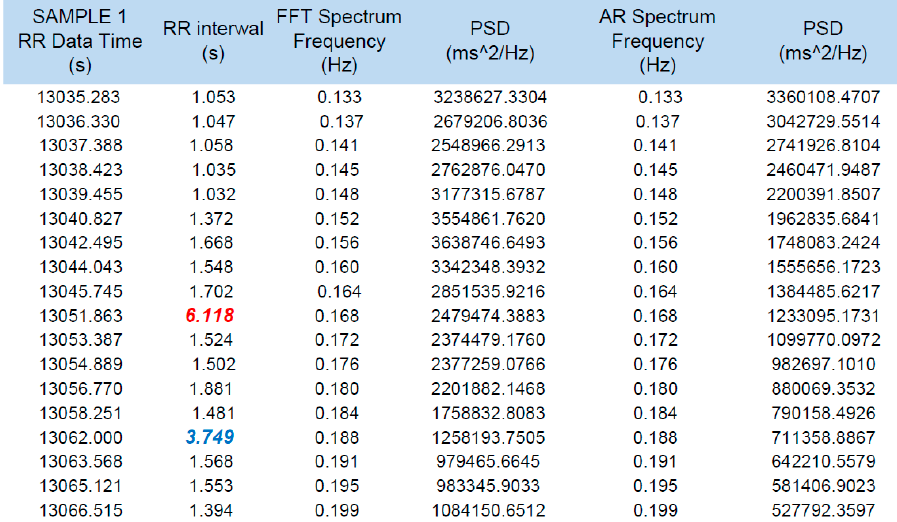
Figure 1. An example of a 30 s HRV printout recorded on an HRM that was compared with the ECG Holter recordings. The R-R interval (column 2) was evaluated while considering the recording time, here given in s after the start of the recording (column 1). The longest interval is 6.118 s, marked in red. The second longest interval is 3.749 s, marked in blue. R-R interval , interval between consecutive beats (i.e., the interval between two R-waves of QRS complexes in ECG); FFT , the fast Fourier transform ; PSD , power spectral density; AR , autoregressive.